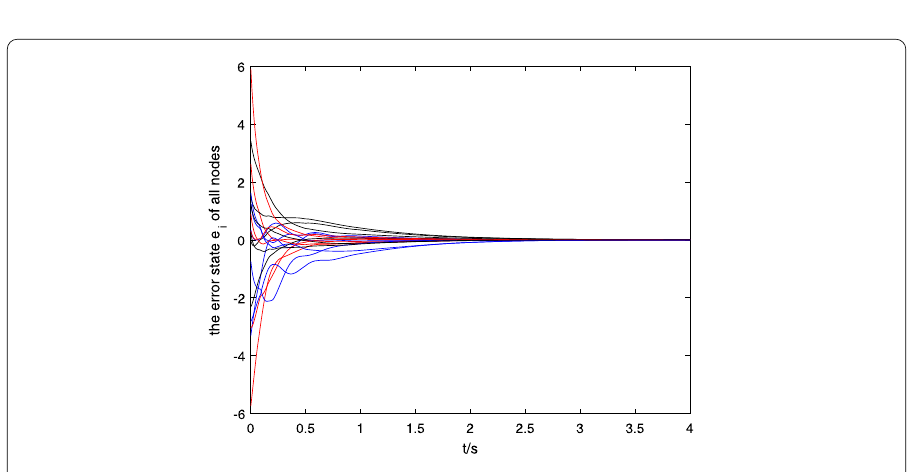
Figure 3 The error state e i of all nodes when h 1 = 3, h 2 = 3, h 3 = 4, h 4 = 5 and θ = 0.3